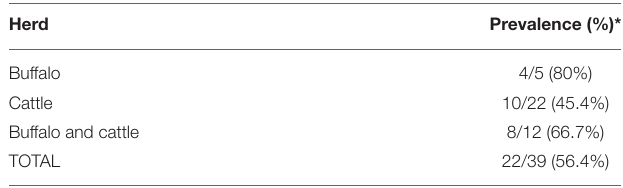
TABLE 5 | M. bovis prevalence by herd in Amazonas State, Brazil.